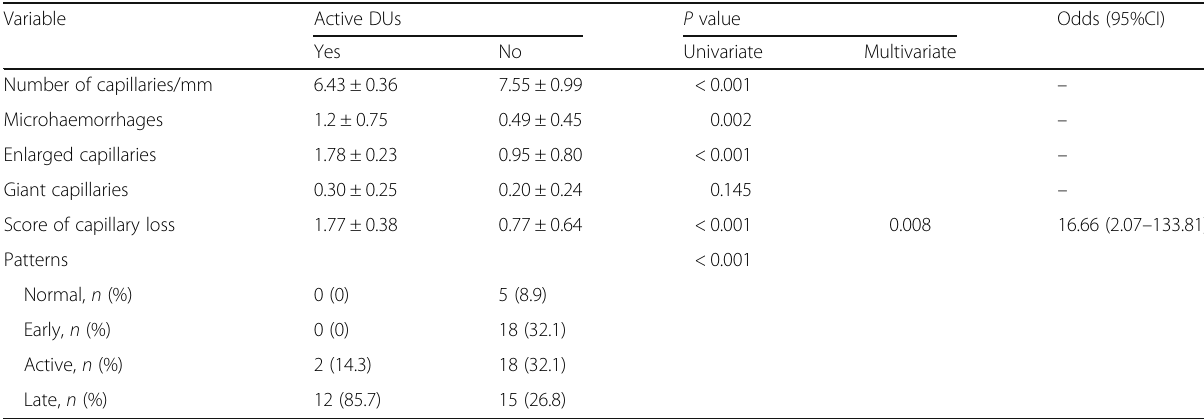
Table 3 Videocapillaroscopy parameters according to the presence or absence of digital ulcers - univariate and multivariate analysis Variable Active DUs P value Yes No Univariate Multivariate Number of capillaries/mm